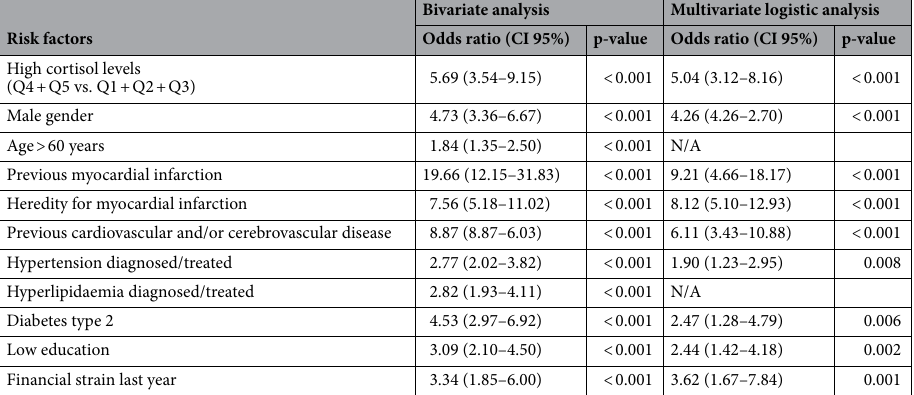
Table 2. Bivariate and multivariate logistic regression of factors associated to risk for myocardial infarction, data for AMI-cases (N = 174) and SCAPIS-controls (N = 3 055). Logistic Regression model: Exp (B) = 21.50, Wald = 1223.3, p < 0.001. Non-significant factors excluded in the reduced multivariate model: Smoking, BMI- Obesity, Autoimmune disease (Inflammatory bowel disease, RA, Bechterews, SLE, Psoriasis), Age over 60 and